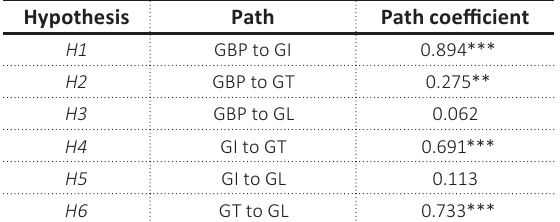
Table 5. Results of SEM